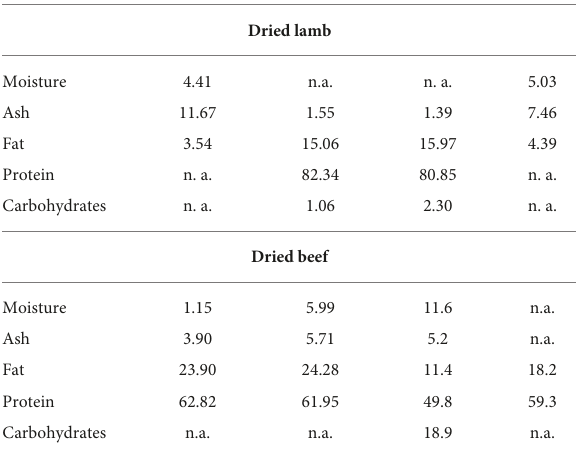
TABLE 4 Comparison of proximate composition of different drying techniques for dried meat products.